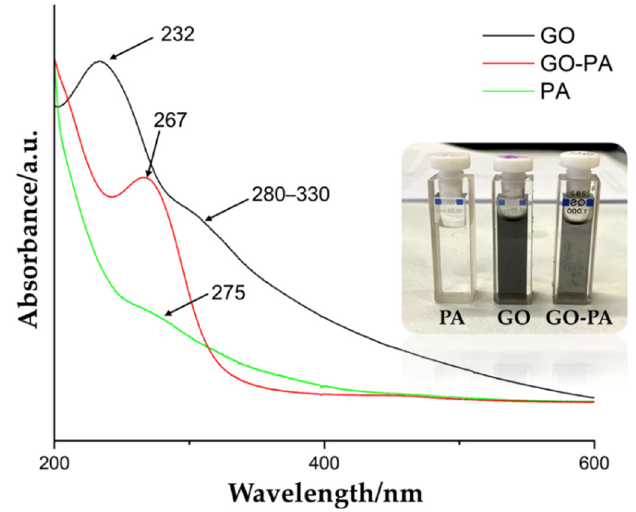
Figure 6. UV–Vis spectra of PA, GO, and GO-PA water dispersions and their visual appearance in the inset.